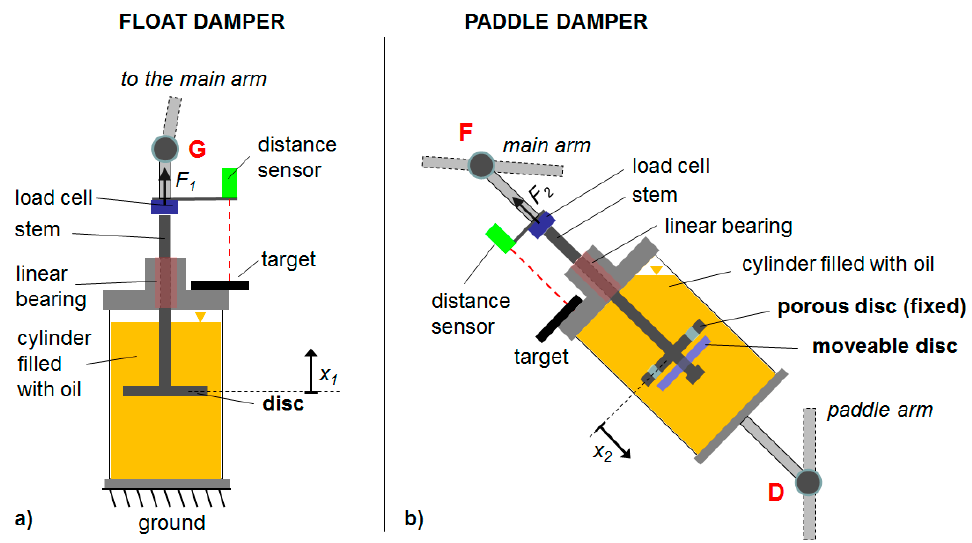
Figure 3. PTO of float ( a ) and paddle ( b ).